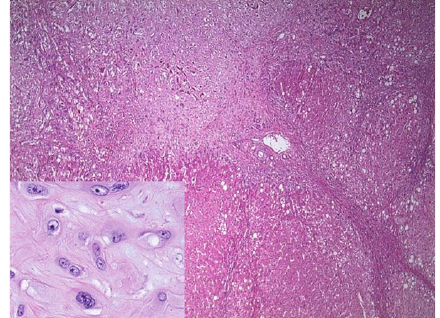
Figure 2: Photomicrograph of explanted liver. Transition zone between HEHE (upper-left corner) and cirrhosis. Inset is high- power view of HEHE showing epithelioid cells with intracytoplas- mic